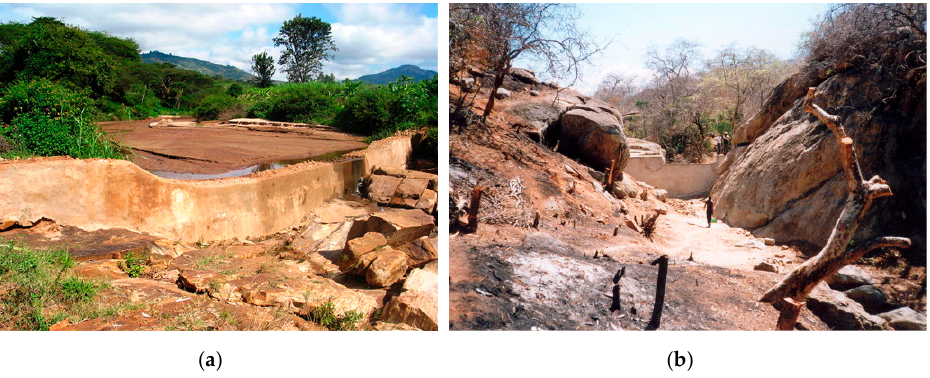
Figure 6. Typical sand storage dams: ( a ) filled sand dam and ( b ) sand dam prior to filling. Photographs reproduced with permission from Ertsen and Hut, Physics and Chemistry of the Earth Parts A/B/C, published by Elsevier (2009).